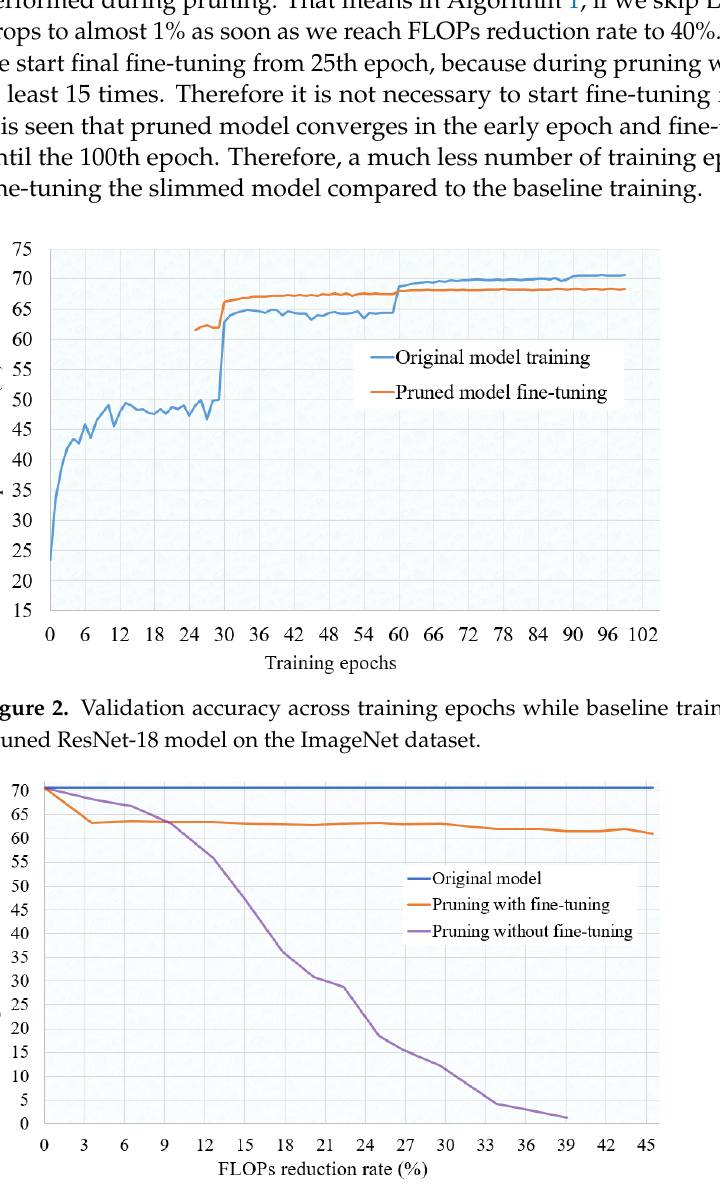
Figure 3. Validation accuracy while pruning the baseline ResNet-18 model on the ImageNet dataset across different FLOPs reduction rates. After every 3% FLOPs reduction, fine-tuning is performed for one epoch to prevent the accuracy